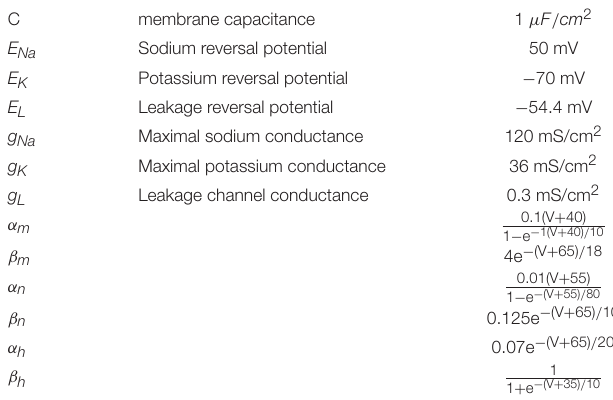
TABLE 1 | Parameters and rate functions of the HH neuron